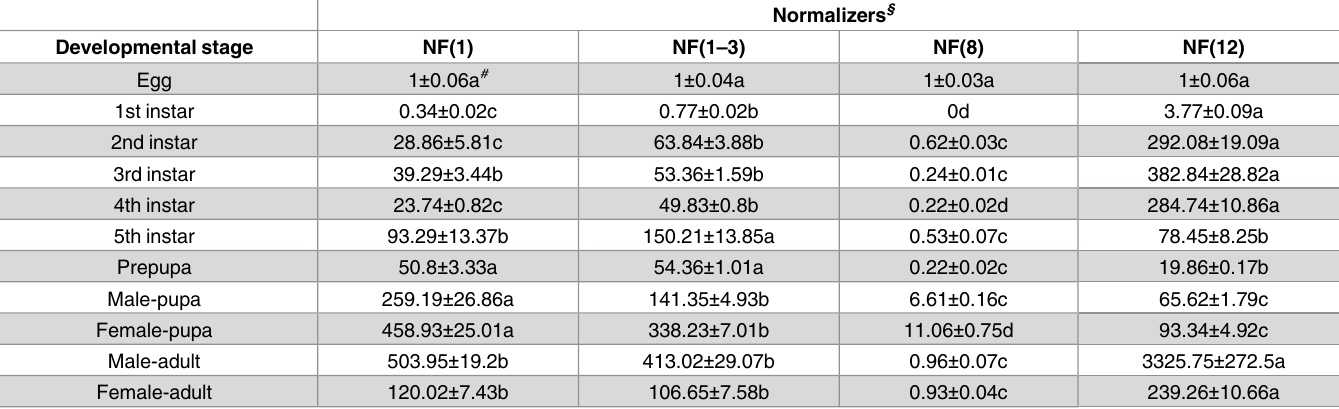
Table 7. Expressional profiles of let-7 in G . molesta quantified according to different normalizers.